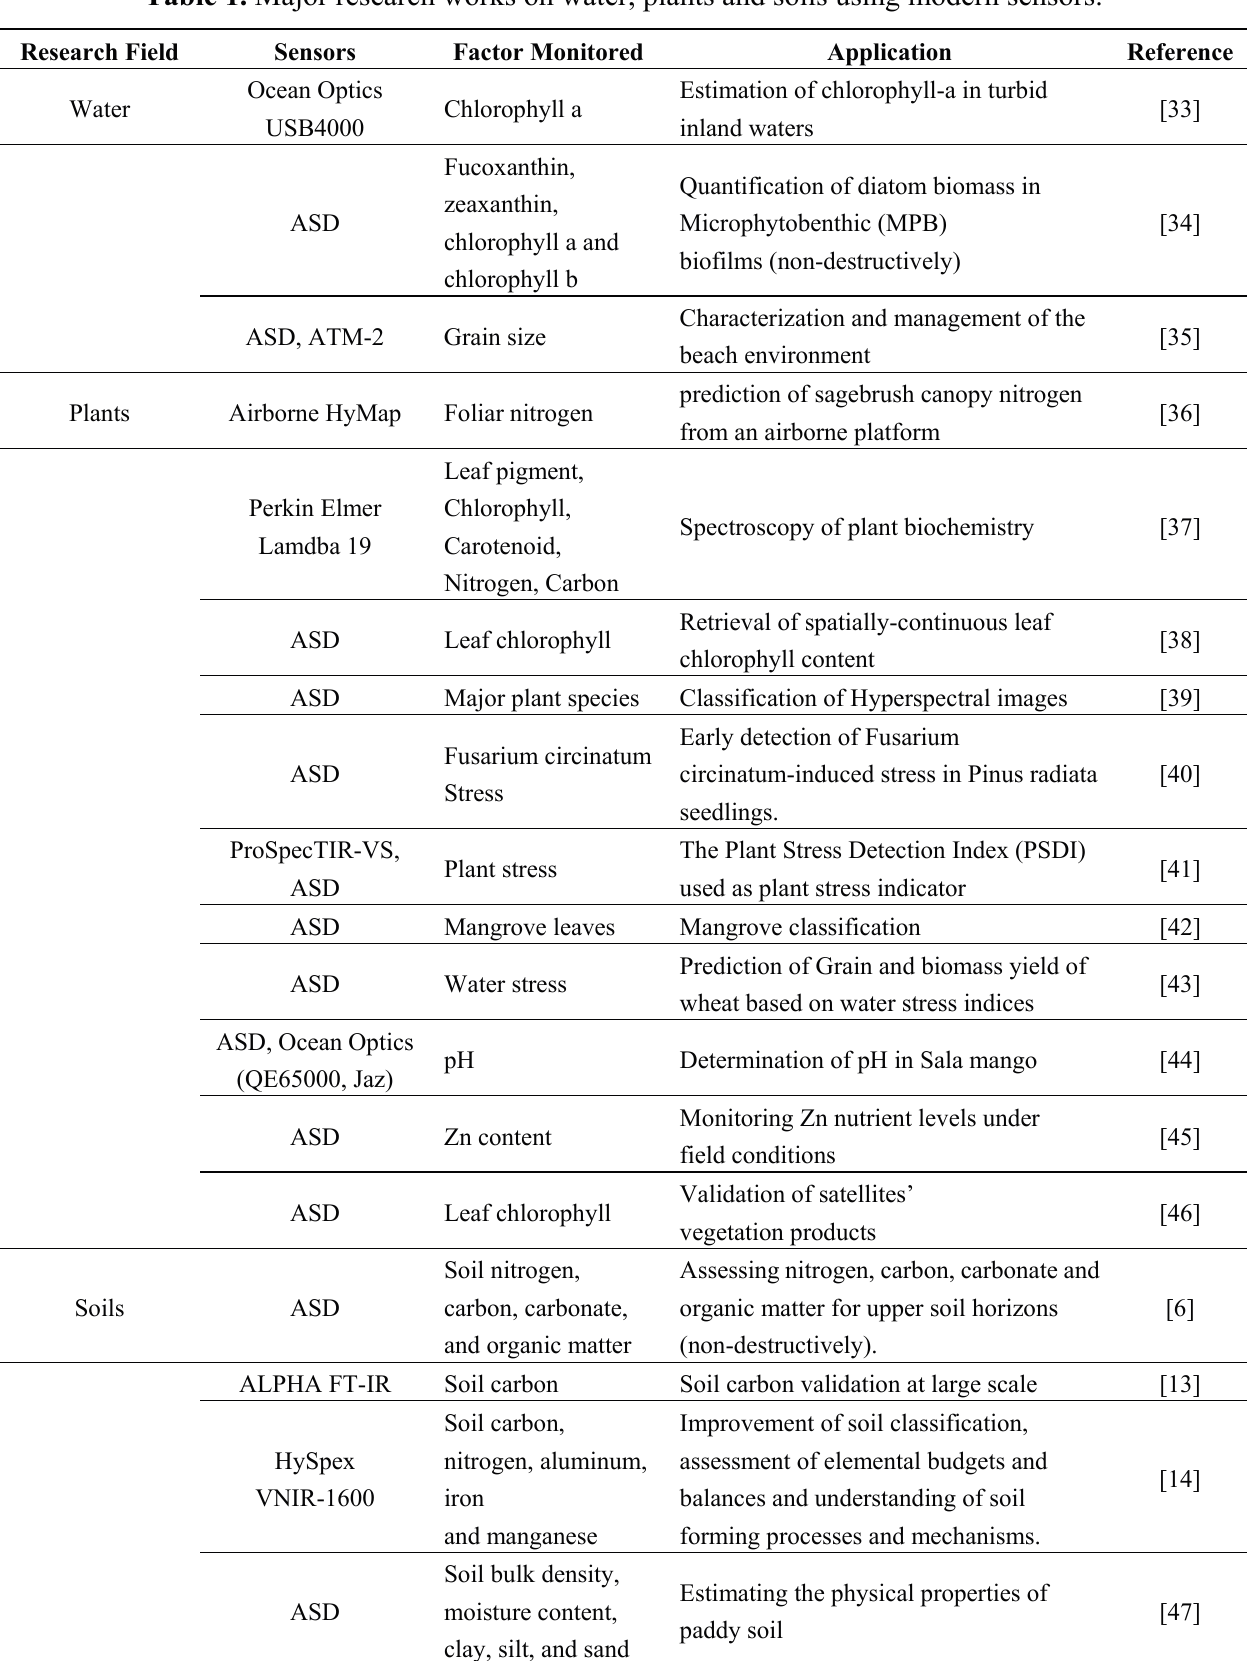
Table 1. Major research works on water, plants and soils using modern